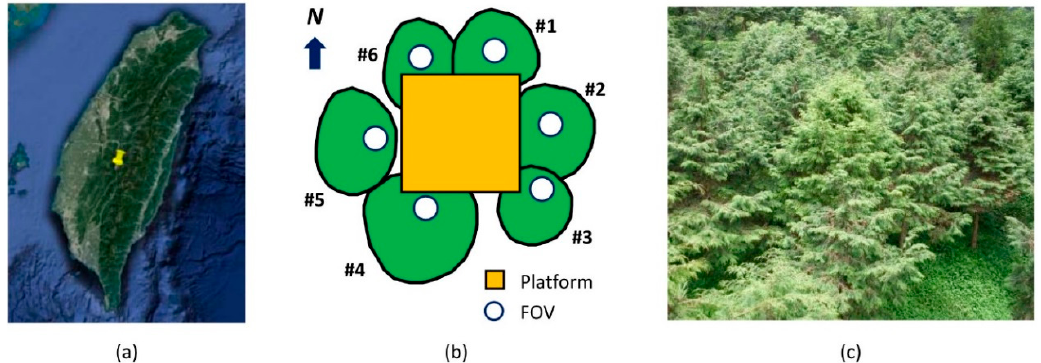
Figure 1. A google map showing the location of the study site ( a ); Trees surrounding the watchtower ( b ); A view of the red cypress stand ( c ).